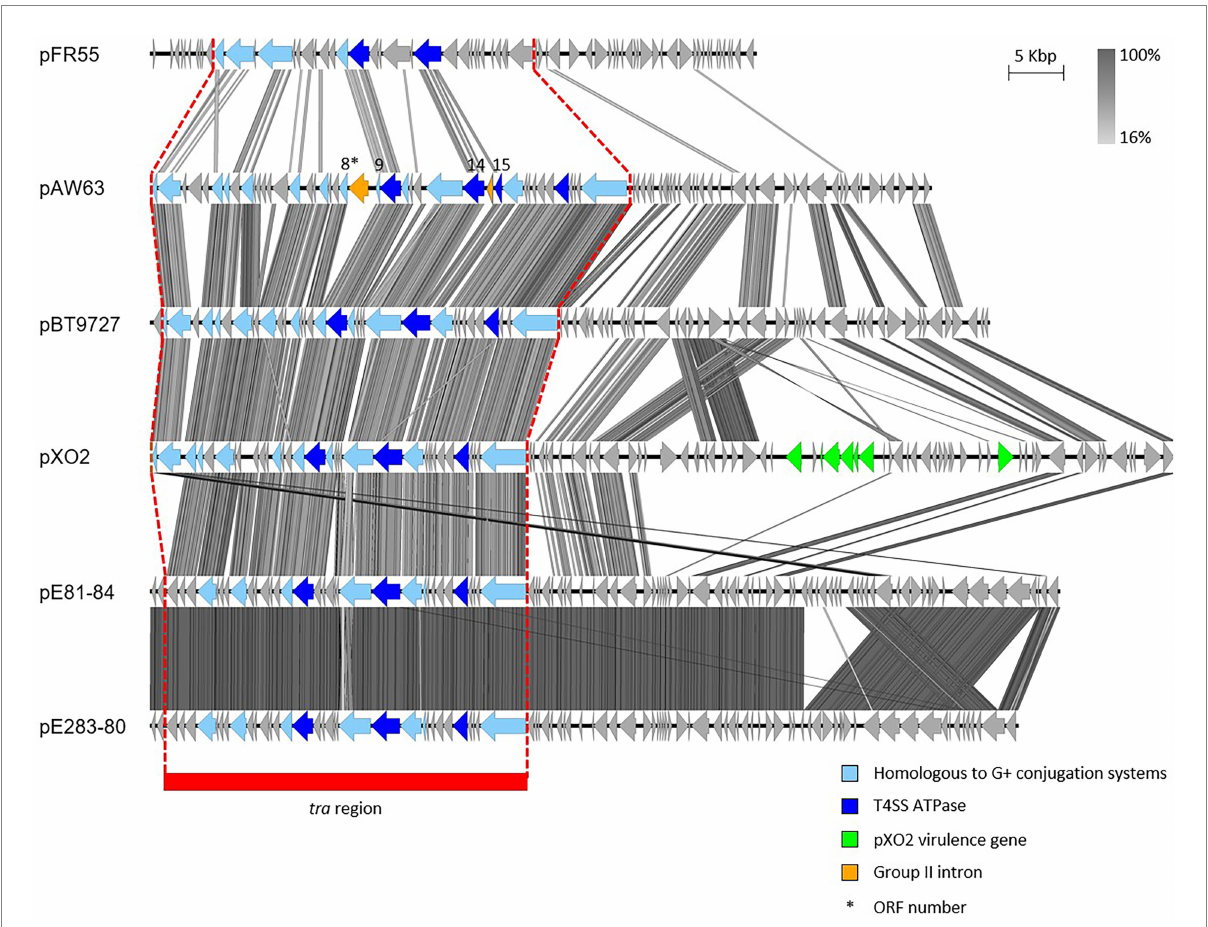
FIGURE 2 Sequence comparison of the (putative) conjugative plasmids of the pXO2-like family. The tra region of the plasmids pFR55, pAW63, pBT9727, pXO2, pE81-84 and pE283-80 share evident similarities. CDS depicted in light blue share homologies with other known conjugative systems; CDS depicted in dark blue are the putative ATPases; both CDS in orange in pAW63 sequence correspond to group II introns interrupting the genes encoded by the CDS 8–9 and 14–15; CDS colored in green encode Cap and Acp virulence factors of pXO2. The region highlighted in red corresponds to the tra region. The image was generated by Easyfig 2.0 software. Genbank accession numbers: pXO2: NC_007323.3; others: Table